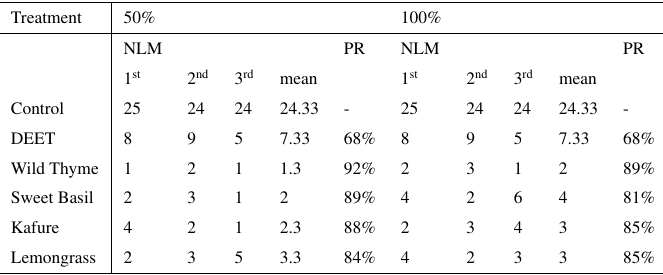
Table 3. Percent repellency (PR) of 50% and 100% of evaluated plants leaves ethanol extract against Anopheles mosquito based on the number of landed mosquitoes